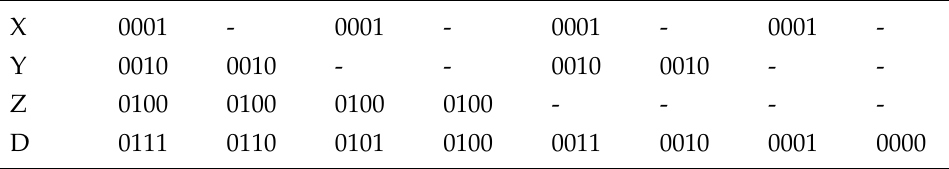
Table 3. How to calculate the value of divisible sides (D) in binary representation.